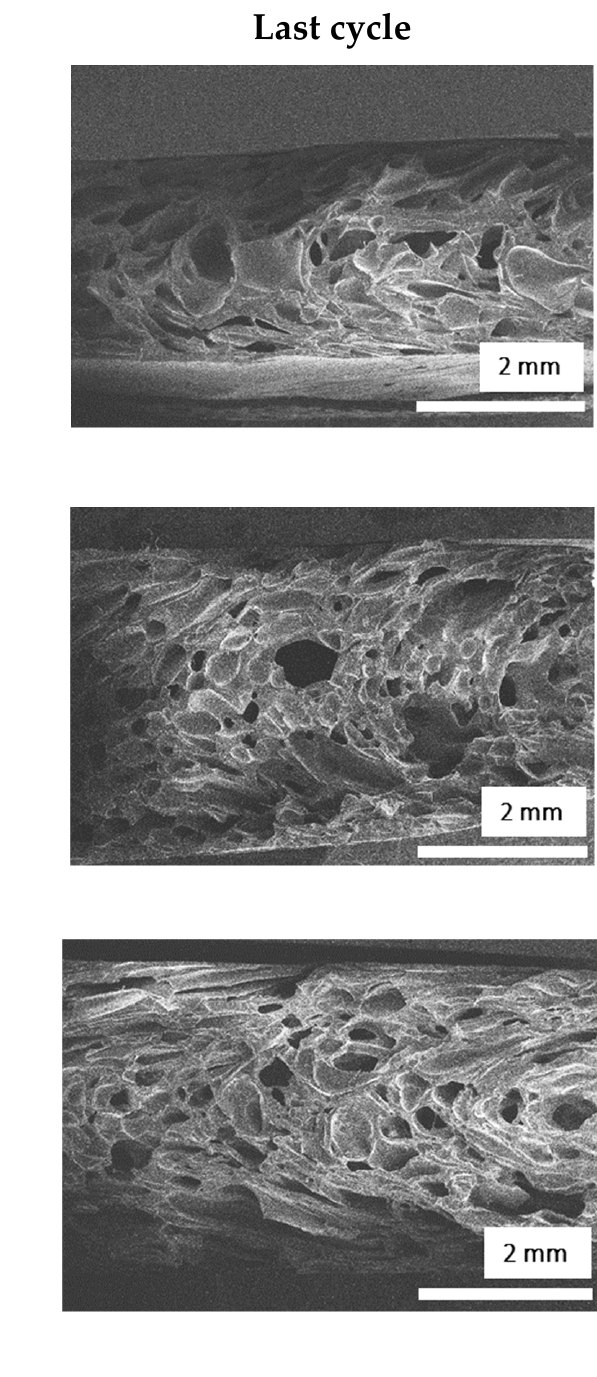
Figure 11. SEM images of NRF after the first absorption test and the last absorption test cycle: ( a ) F-00, ( b ) FH-05, and ( c ) FS-03 samples.